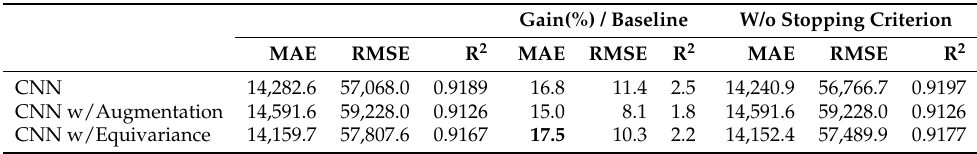
Table 8. Results obtained when applying equivariance to transformations over the model for the overall amount of national